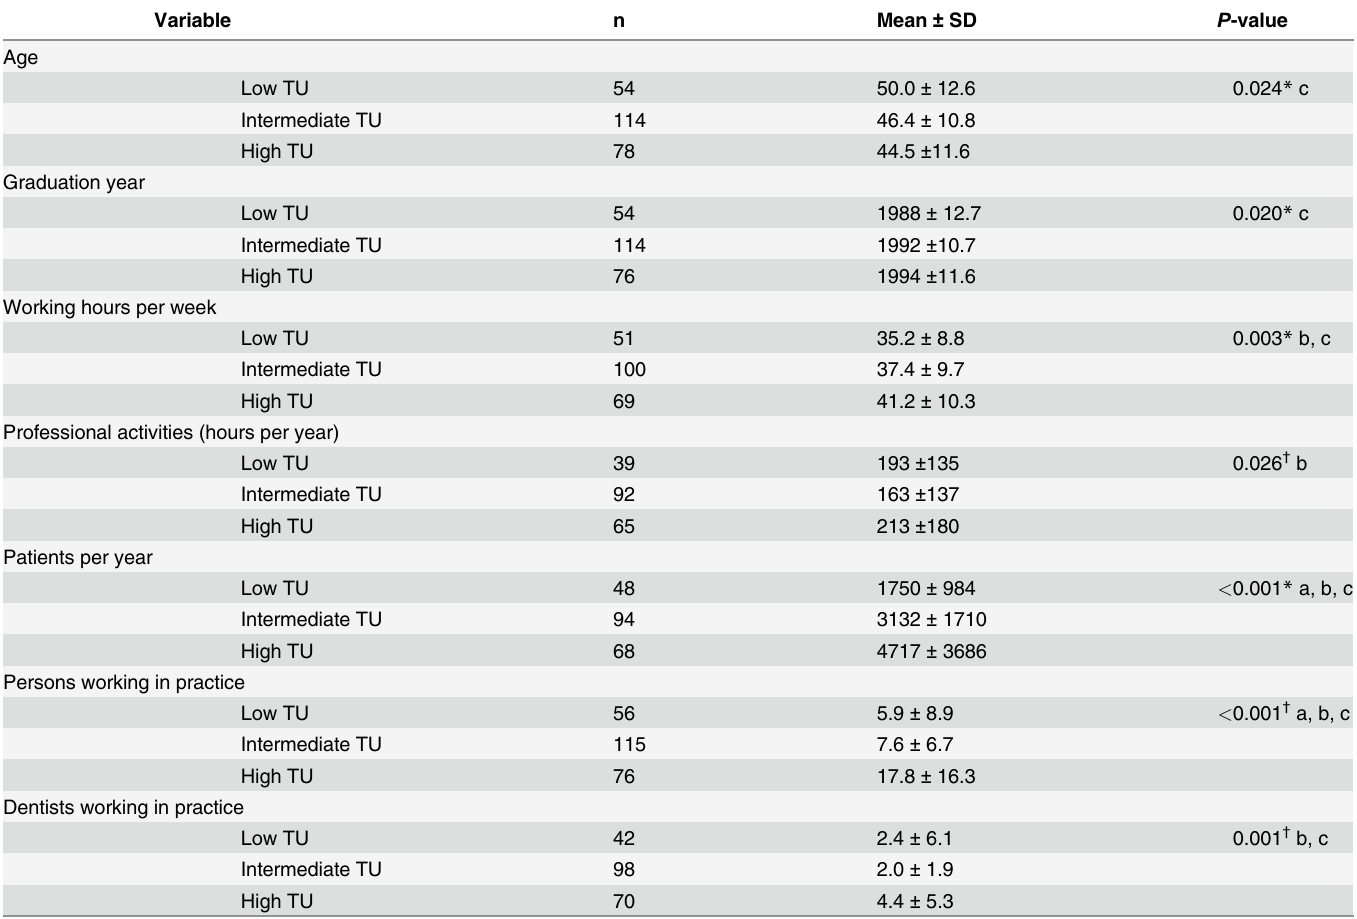
Table 3. Distribution of personal and practice characteristics by degree of technology